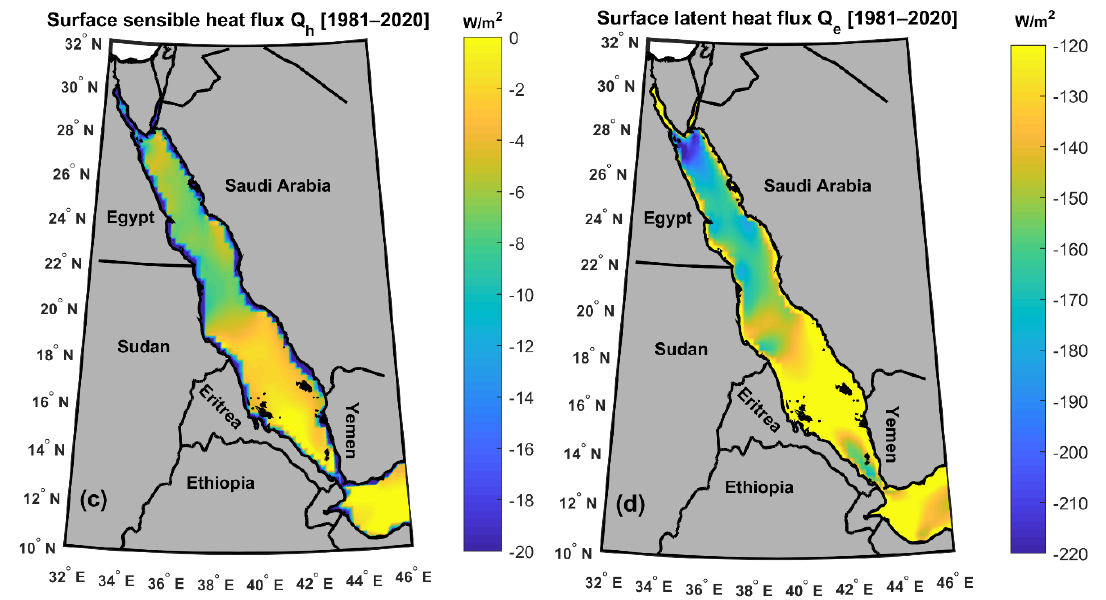
Figure 2. Spatial distribution for the surface net heat flux components (W/m 2 ) in the Red Sea over the study period (1981–2020): ( a ) surface net longwave backscatter radiation (Q b ); ( b ) surface net shortwave solar radiation (Q s ); ( c ) surface sensible heat flux (Q h ); ( d ) surface latent heat flux (Q e ).